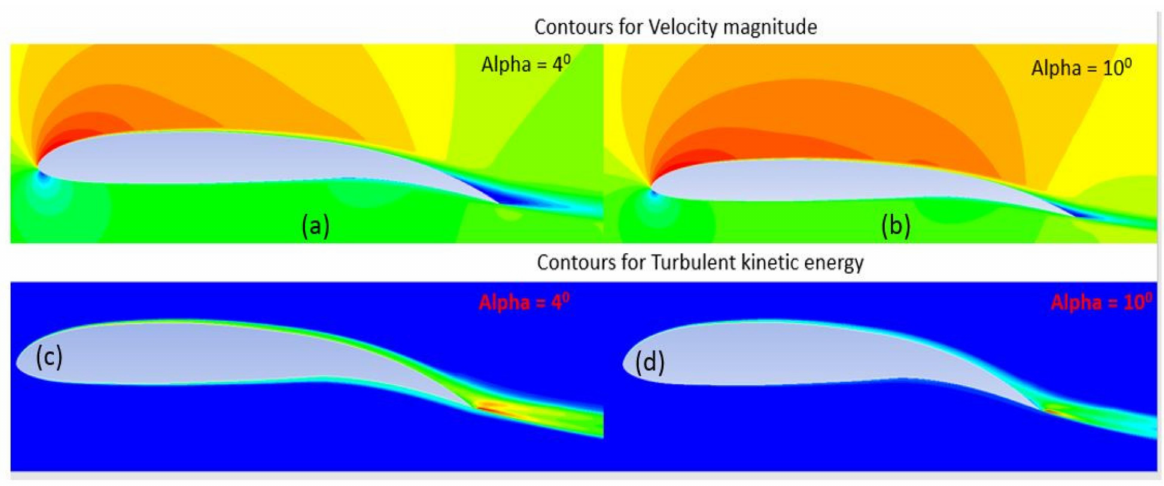
Figure 26. Velocity magnitude and Turbulent Kinetic Energy (TKE) contour plots. ( a ) Velocity contour lines at low angles of attack such as 4 ◦ ; ( b ) Velocity contour lines at low angles of attack such as 10 ◦ ; ( c ) the turbulent intensity at a low angle of attack of 4 ◦ ; (d) the turbulent intensity at a low angle of attack of 10 ◦